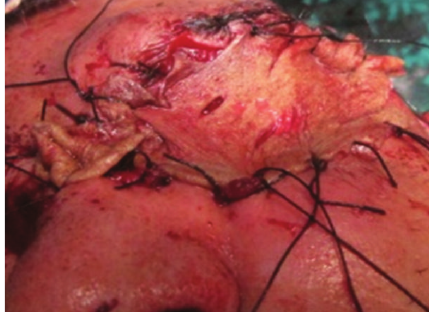
Figure 7: Skin graft.